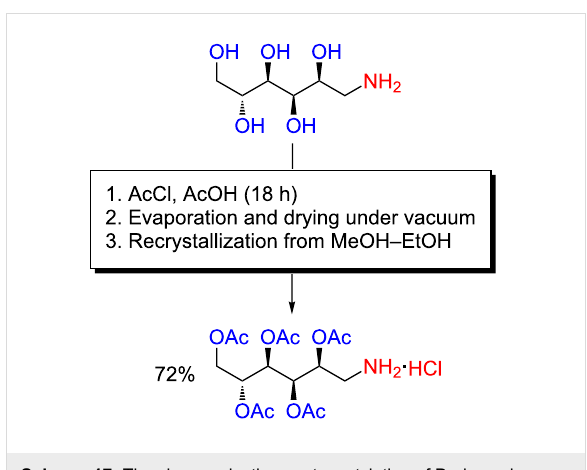
metric Diels–Alder reactions between cyclopentadiene and